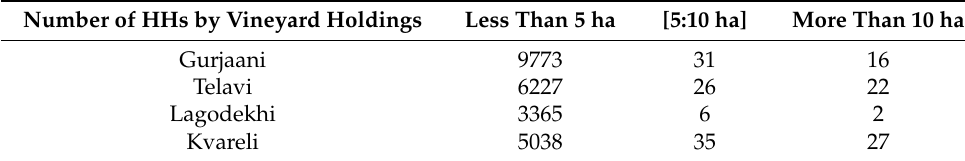
Figure 6. Absolute and percentage number of HHs holding vineyards in targeted municipalities. Table 7. Utilization of land cultivation equipment and trucks (number of HHs). Number of HHs by Vineyard Holdings